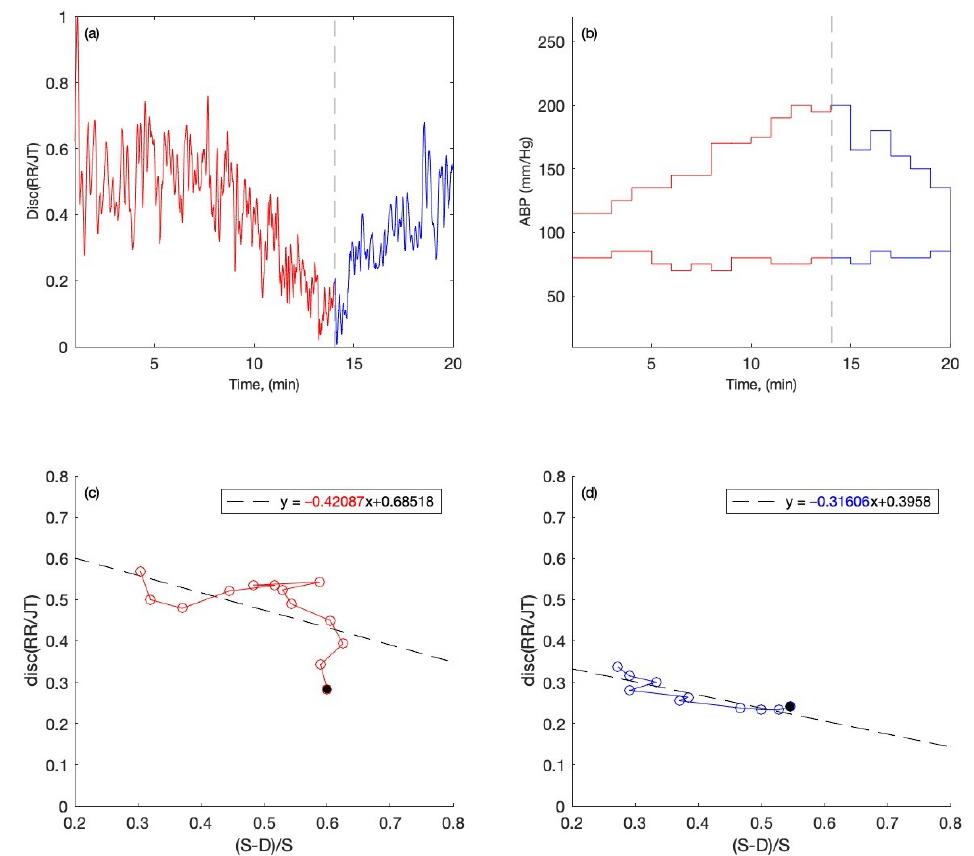
Figure 3. The readings are presented for the person with normal ABP. ( a ) Disc (RR/JT) changes up to 14 min during the load and after 14 min during recovery. ( b ) Variations in Systolic and Diastolic ABP during the stress test. ( c ) The phase plane for the parameters X = (S − D)/S and Y = Disc (RR/JT) and the linear regression plot, where the data for each parameter are presented as a one-minute mean during the load and ( d ) during the